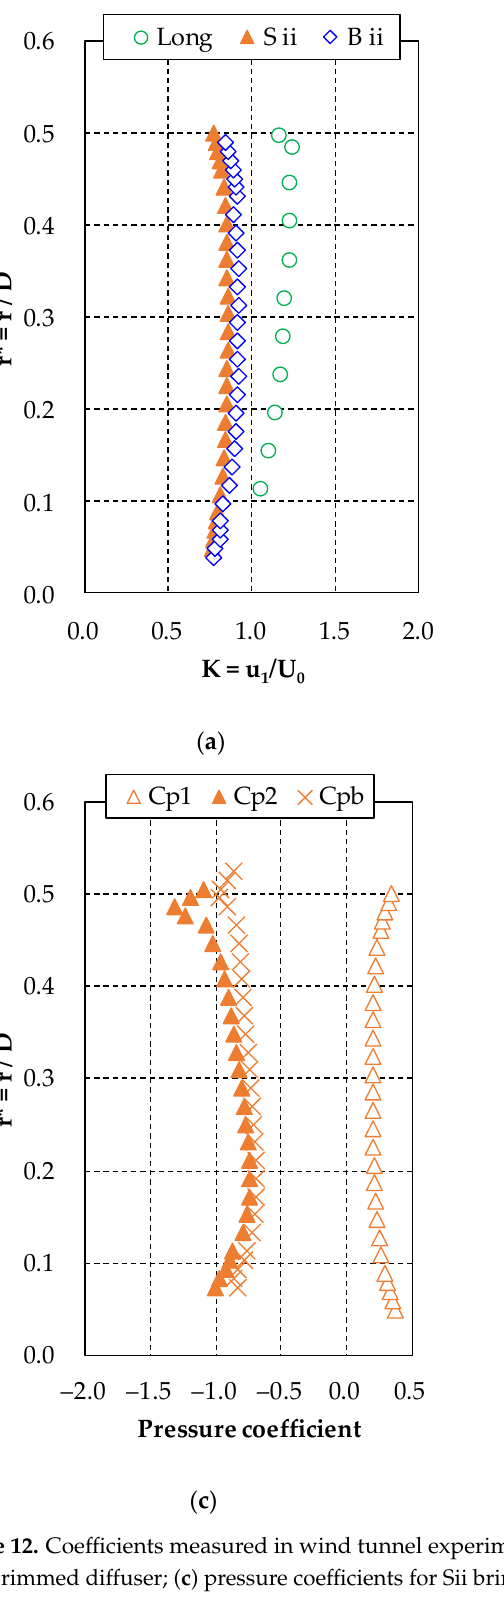
Figure 11. Power curves vs. λ (tip speed ratio) for a wind turbine with compact brimmed diffusers of Sii, Bii and a bare turbine. C w is the output power coefficient.